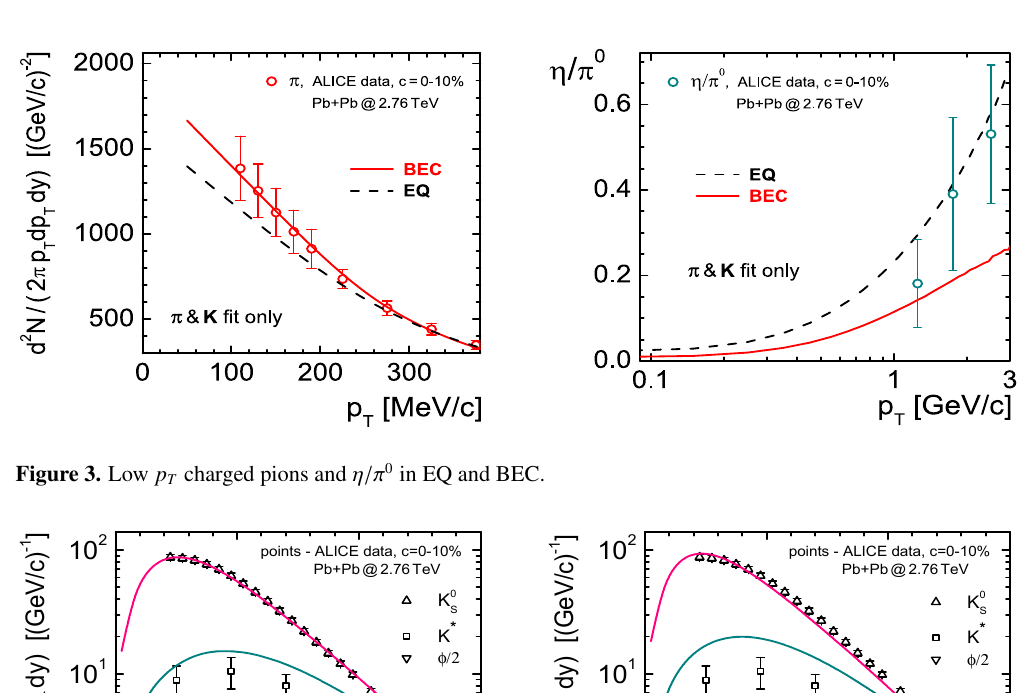
account. The corresponding BEC fit of pion and kaon spectrum gives a good description of protons,